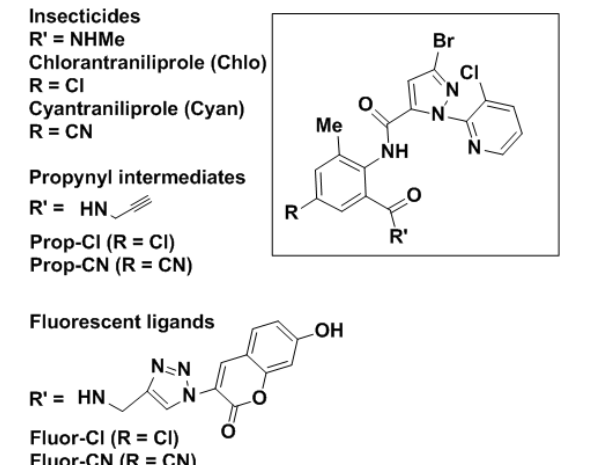
Figure 1. Anthranilic diamide skeleton common to two major commercial insecticides and four analogs with N -propynyl and N -hydroxycoumarin